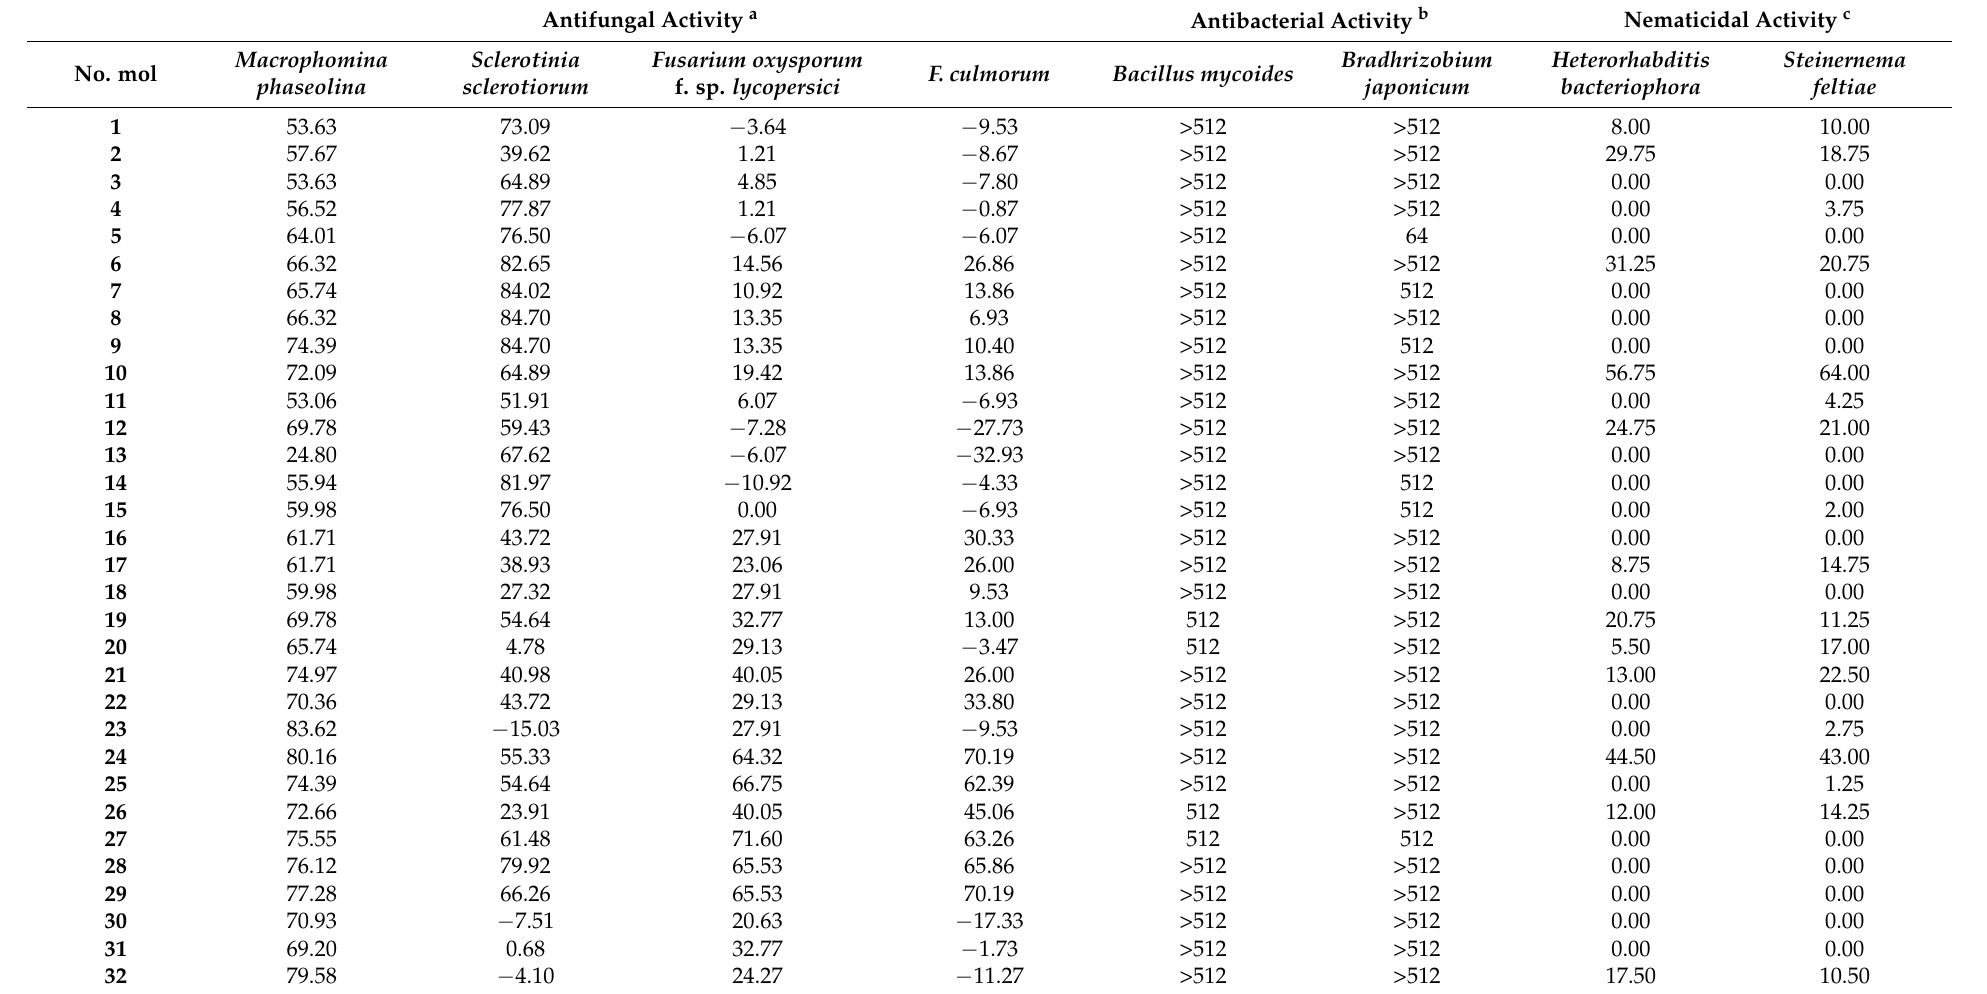
Table 2. Results of antifungal, antibacterial and nematicidal activity of 38 coumarin derivatives. ( a inhibition rate %, 48 h after inoculation at the concentration 0.08 µ mol/mL; b